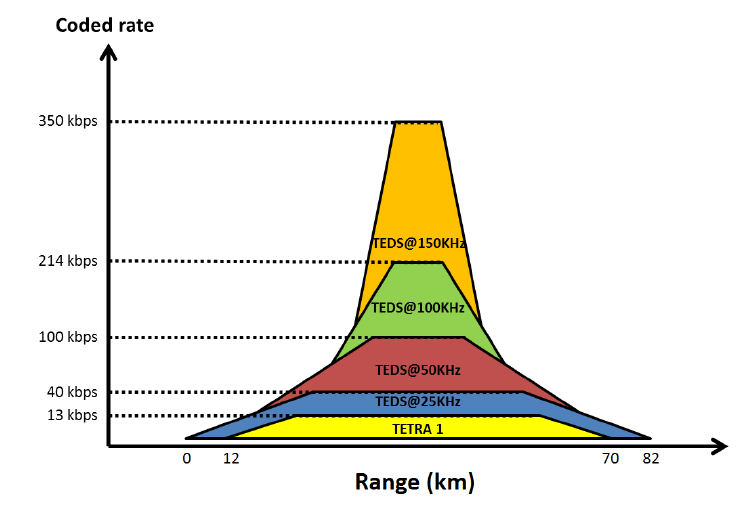
Figure 5. TETRA Enhanced Data Service (TEDS) bandwidth and